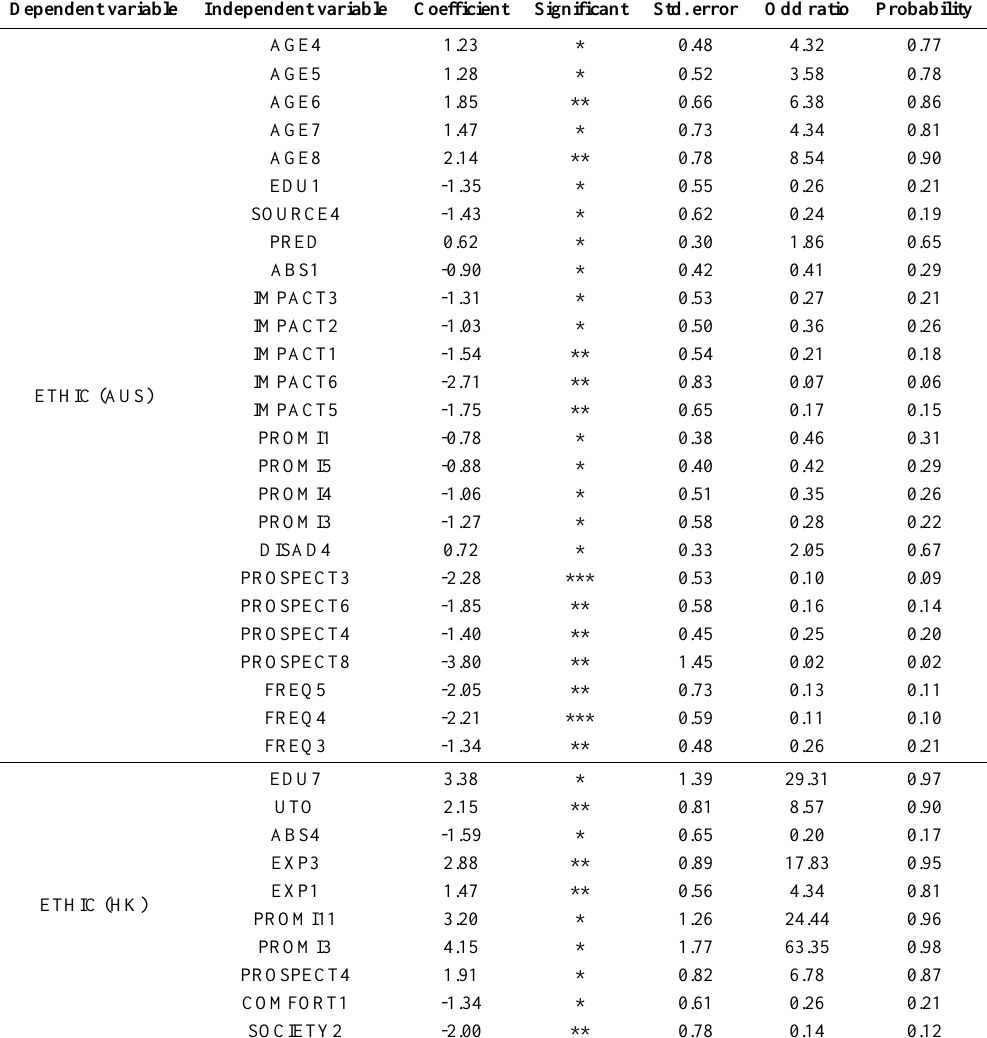
Table B-7. Ethical concerns on AI of the local community Dependent variable